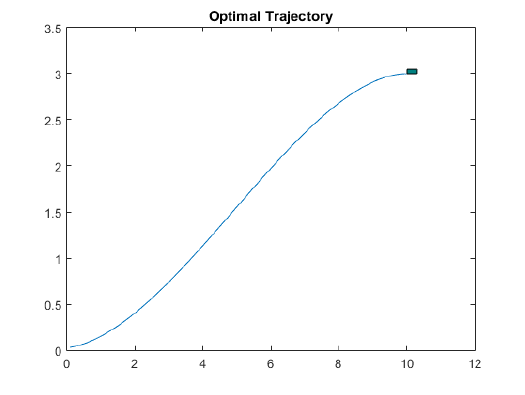
Figure 3. State trajectories x 1 , x 2 and x 3 .